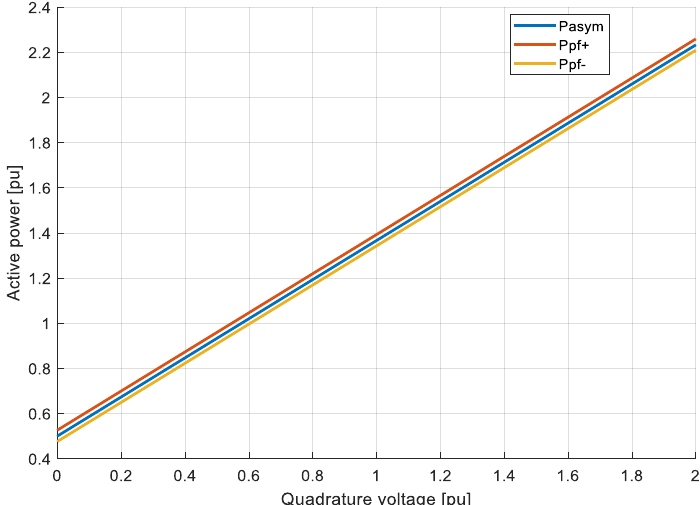
Figure 3. ACPST active power flow for 95% Un (yellow), Un (blue), and 105% Un (red).